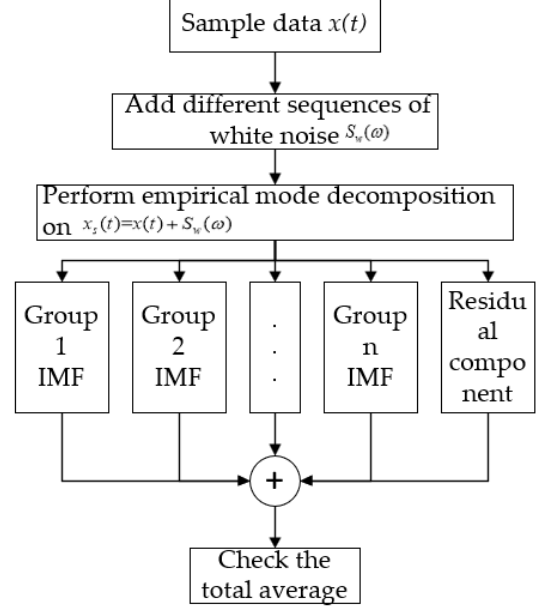
Figure 2. EEMD flow chart.